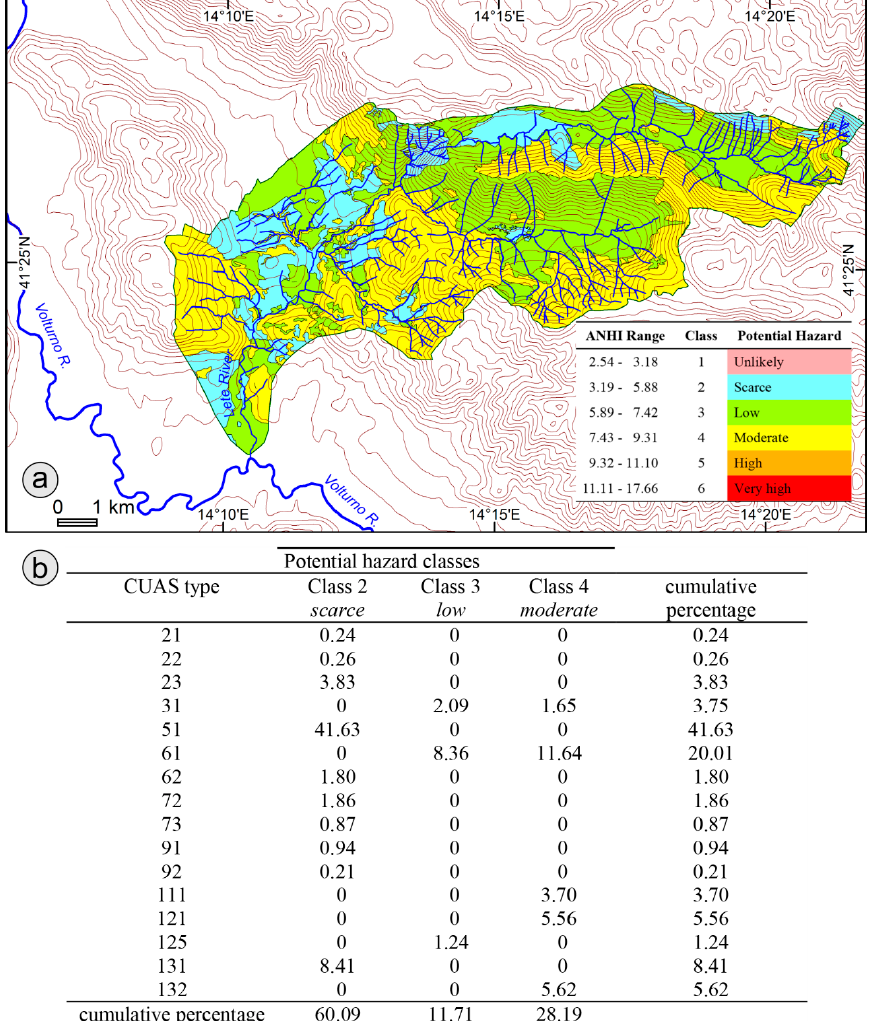
Figure 5. ( a ) Agricultural Nitrate Hazard Index map; in legend classification of Agricultural Nitrate Hazard Index (ANHI) with the related scores assigned to each class; ( b ) percentage value of potential hazard class related to the Agricultural Soil Use Map (Carta dell’Uso Agricolo del Suolo—CUAS)